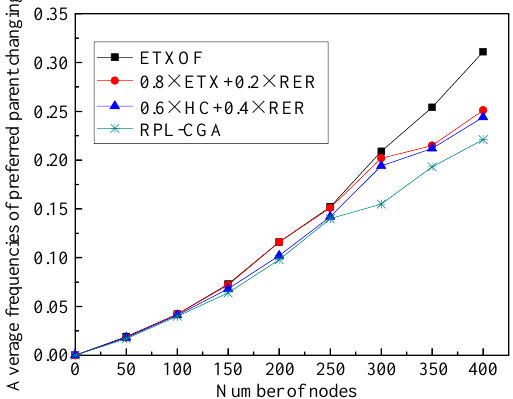
Figure 8. Average frequencies of preferred parent changing.